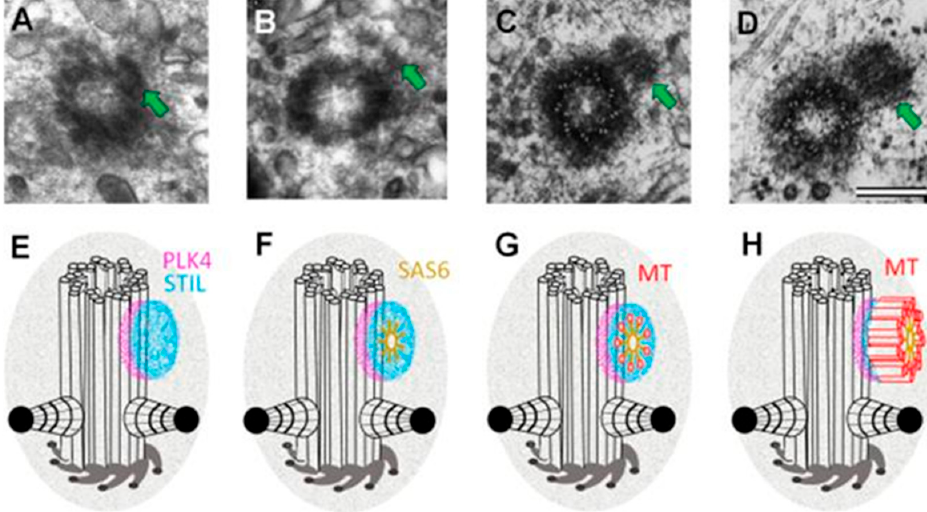
Figure 4. Ultrastructure of the early stages of centriole formation on the mother centriole in the G1 phase of the cell cycle (( A , B )—from [18,35,36] with modifications) and localization of the proteins involved in this process ( E , H ) after [32,37]). The photographs show cells of the porcine embryonic kidney line (SPEV) fixed after mitosis at a time significantly less than the average ( B ) or even minimum ( A , C , D ) duration of the G1 phase of the cell cycle for this cell line [38]. ( A , E )—at the stage of a dense disc, a complex of PLK4 kinase and STIL protein is formed on the centriole surface. ( B , F )—at the stage of the removed disk, 9 dimers of the SAS6 protein are added to this complex, which, due to the interaction of their lateral domains, form the “cartwheel structure”. ( C , G )—nucleation of centriole microtubules occurs at the ends of the “cartwheel structure” spokes; the figure shows MT singlets. ( D , H )—MT singlets are completed to MT doublets and further to MT triplets. The length of procentrioles at the end of the G1 phase of the cell cycle is about 100 nm; further elongation of triplets is activated when the cell enters the S phase of the cell cycle. On the surface of the mother centriole, the schemes show 9 distal appendages and two subdistal appendages (such a number of subdistal appendages is typical for this cell line). Microtubules extending from the heads of subdistal appendages and pericentriolar material are not shown in the diagrams. Arrows show procentrioles. The photo and diagrams show only one (mother) centriole from a pair. It should be noted that the mother centriole in the diagrams is shown when viewed from the proximal end and the triplets are twisted counterclockwise at this point of view, the procentriole is shown when viewed from the distal end, so the triplets in the diagram are twisted clockwise [2]. Scale bar 200 nm.